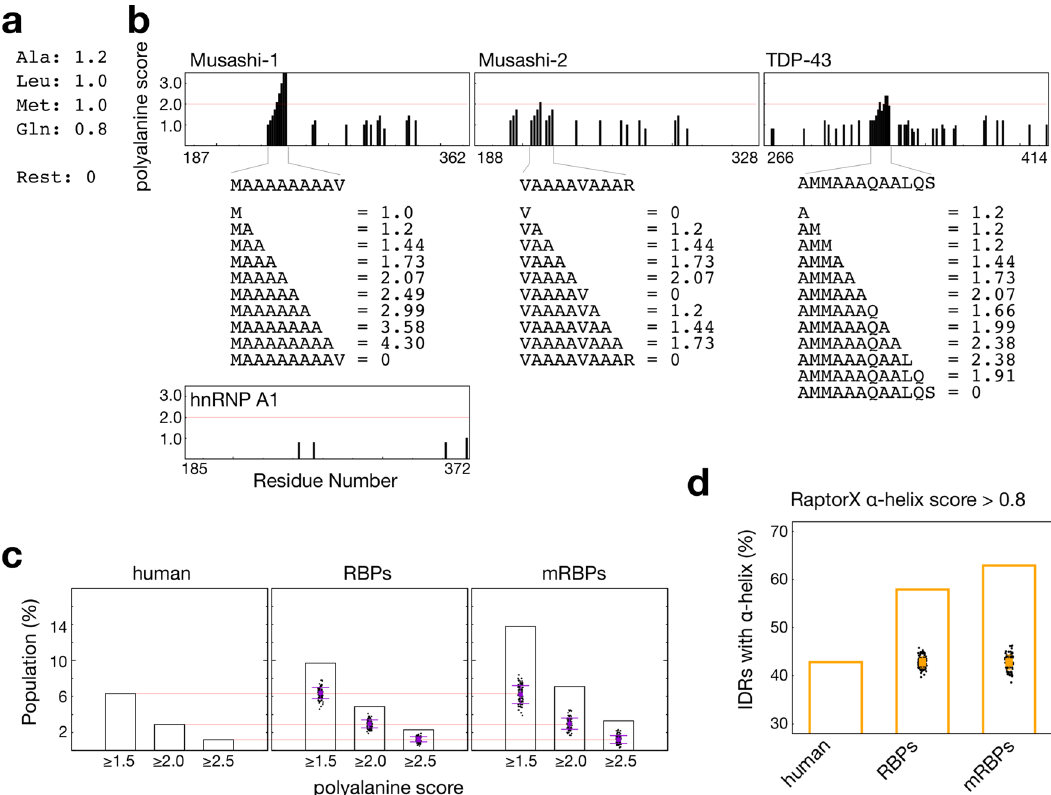
Fig. 5 Estimated prevalence of polyalanine and α -helix-forming residue stretches in the intrinsically disordered regions. a Tentative scores are assigned to the amino acids according to the experimental observation to estimate the frequency of polyalanine appearance. b Examples of how polyalanine propensity scores were calculated for continuous residue stretches of increasing length in proteins with α -helix-forming regions (Musashi-1, Musashi-2, and TDP-43) or without (hnRNP A1). c Prevalence of IDRs with polyalanine scores greater than 2.5, 2.0, and 1.5, in the human proteome, RNA-binding proteins (RBPs), and mRNA-binding proteins (mRBPs). d Population of IDRs with α -helical elements longer than fi ve consecutive residues in the human proteome, RBPs, and mRBPs. The point clouds, square points, and error bars in the RBP and mRBP panels are the distribution, mean, and standard deviation of the polyalanine (panel c ) and α -helix scores (panel d ) of 100 random selections of sets of 1542 or 689 proteins (the RBP and mRBP sample sizes) from the human proteome (as negative